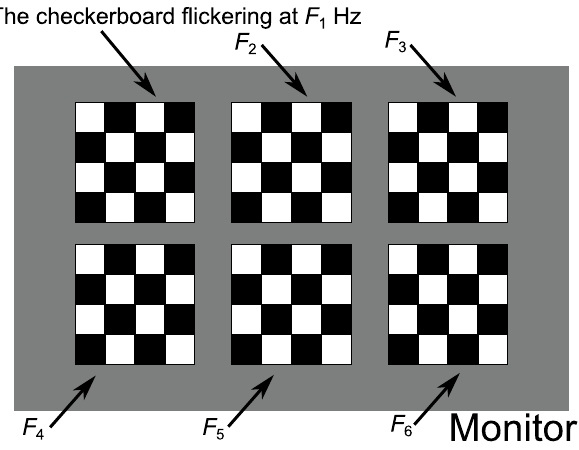
Figure 9. An instance of steady-state visually evoked potentials-based brain–computer interfacing: Each checkerboard performs monochrome inversion at a different frequency.